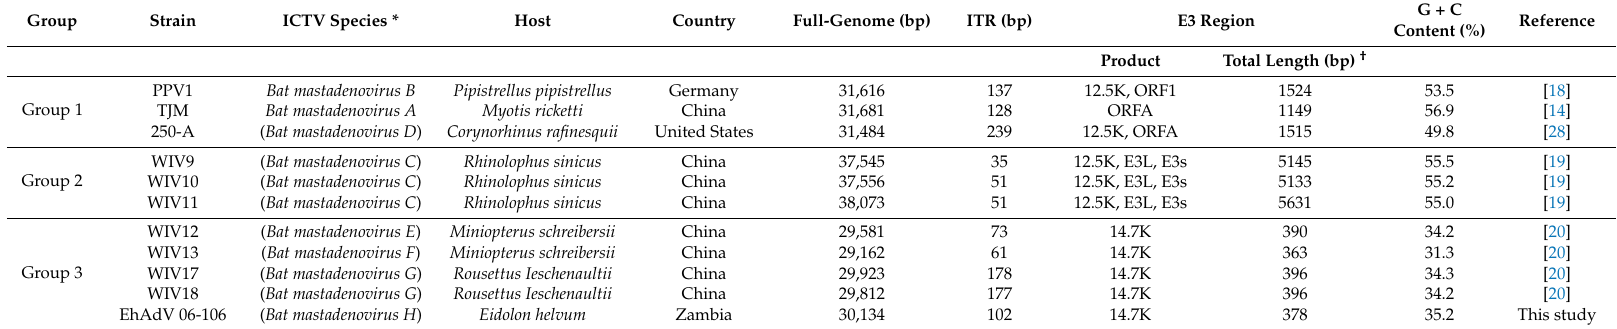
Table 1. Grouping of 11 bat adenoviruses with reported full-length genome sequences and comparisons among the groups.